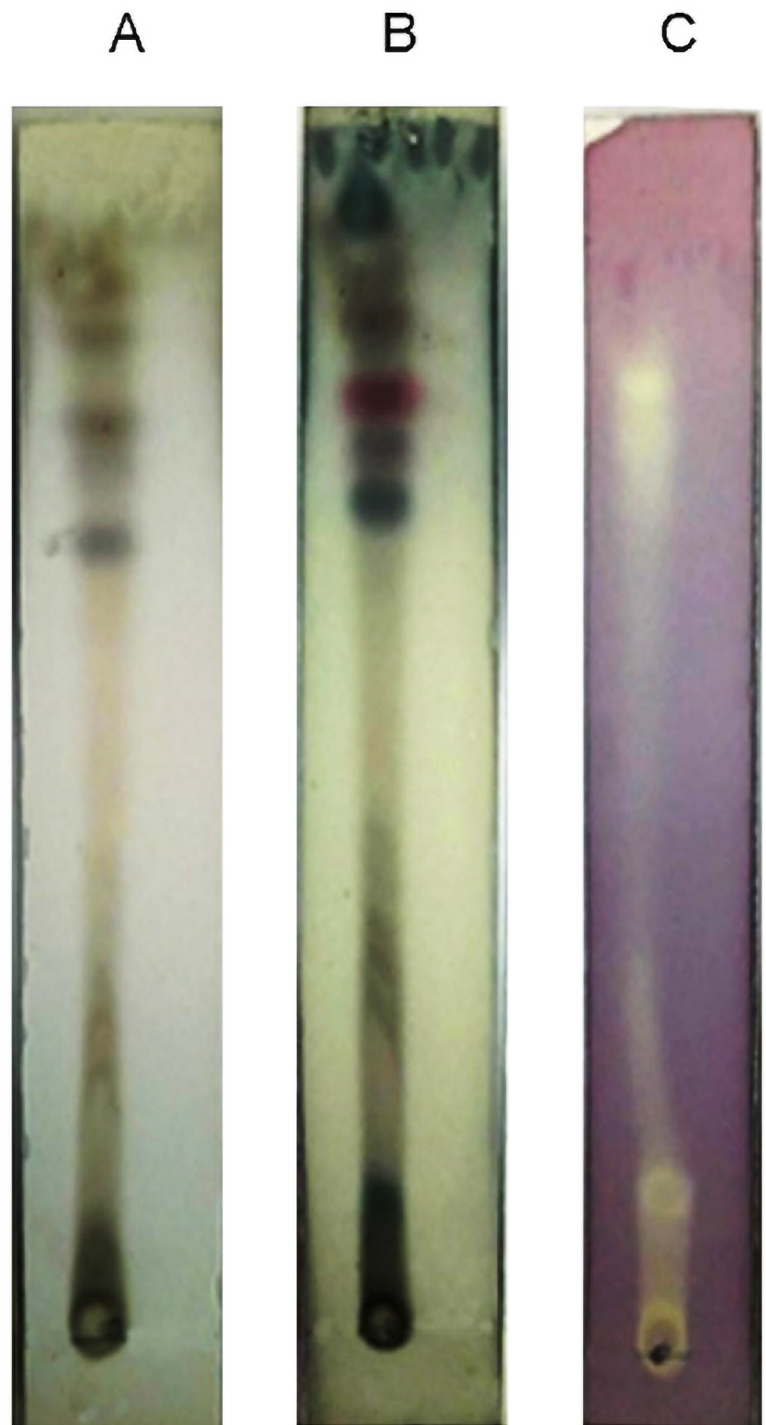
Fig 6. TLC photography of fungal extract. These fractions were developed in a preselected solvent system containing chloroform /methanol (8:2, by volume) and visualized using several methods, namely, ultraviolet lamps emitting at 365 nm after heating for 3 min at 105 ˚C after spraying with vanillin sulphuric acid (A), ultraviolet lamps emitting at 365 nm after spraying with anisaldehyde-sulphuric acid solution (B), and 0.04 mg � mL − 1 DPPH in ethanol (C).